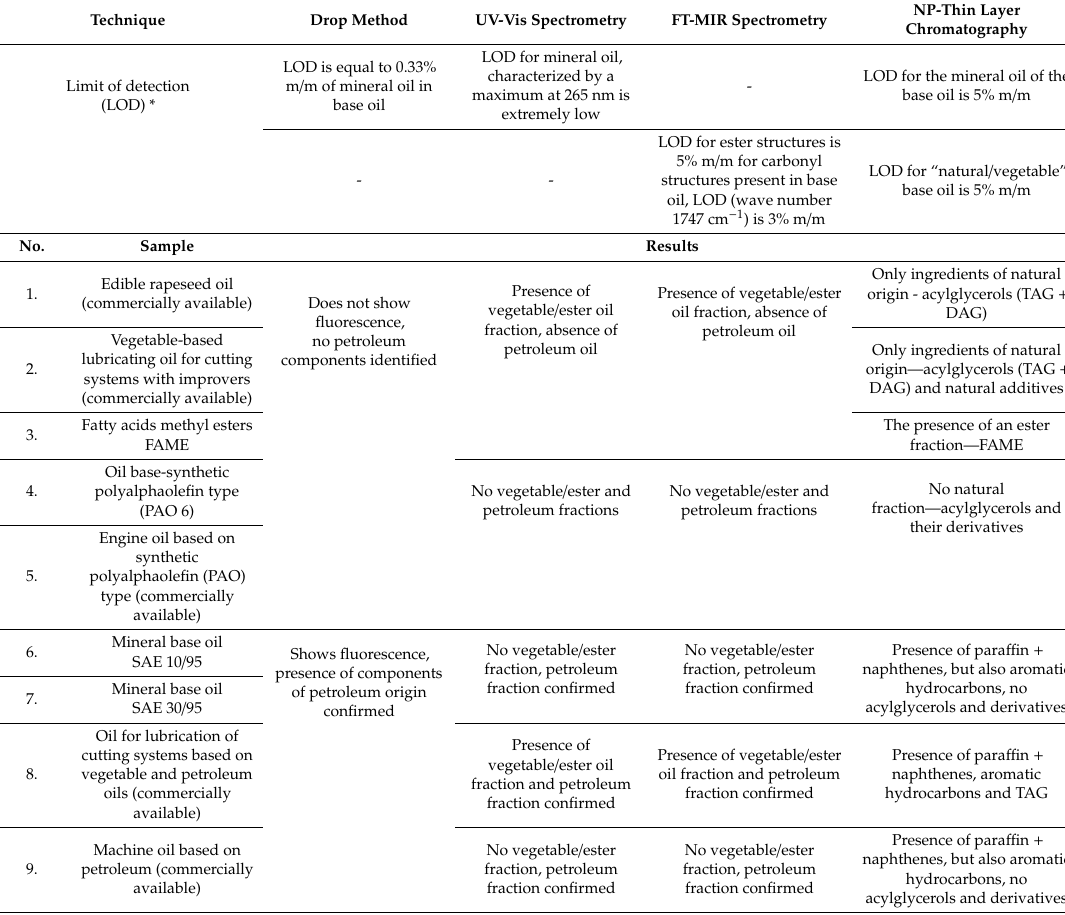
Figure 3. Fluorescence of mixtures of vegetable and petroleum oil in various proportions (by mass) illuminated with a UV LED lamp, λ = 365 nm.